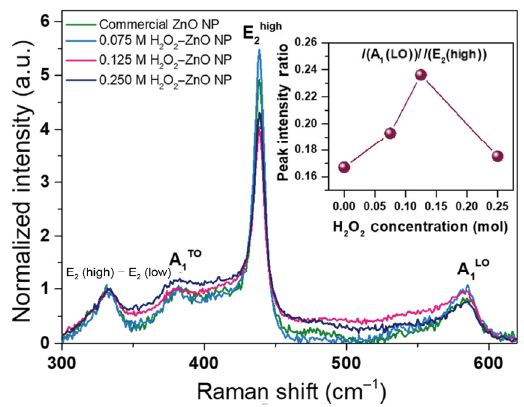
Fig. 7 Raman spectra of commercial ZnO NPs and x M H 2 O 2 treated/annealed ZnO NPs ( x = 0.075, 0.125, and 0.250).